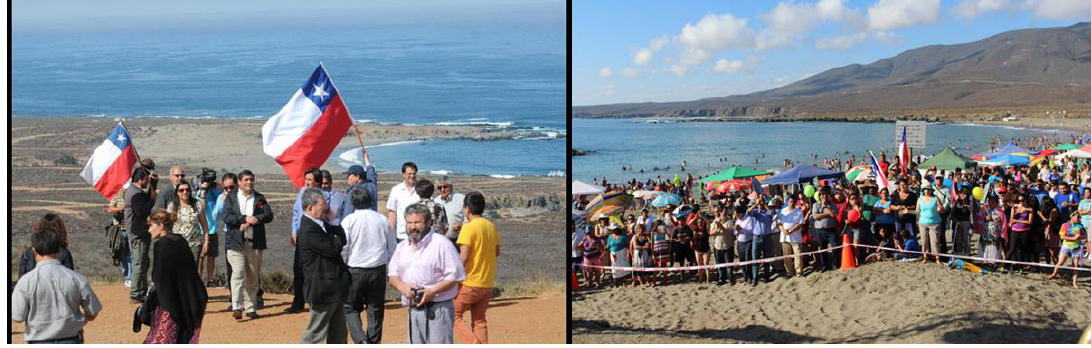
Figure 4. Celebration of the re-opening of the Agua Dulce Beach in February 2015, Source: [54,55]